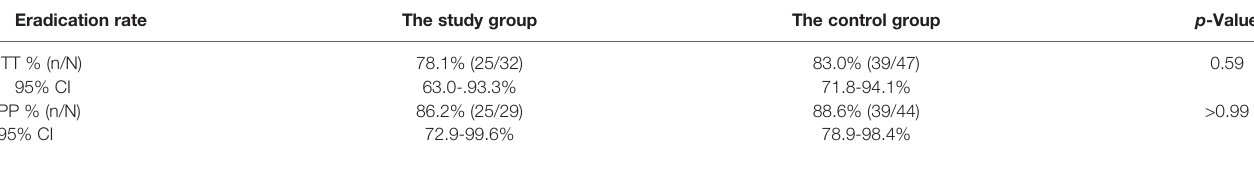
TABLE 4 | The eradication rate of the second stages of treatment.